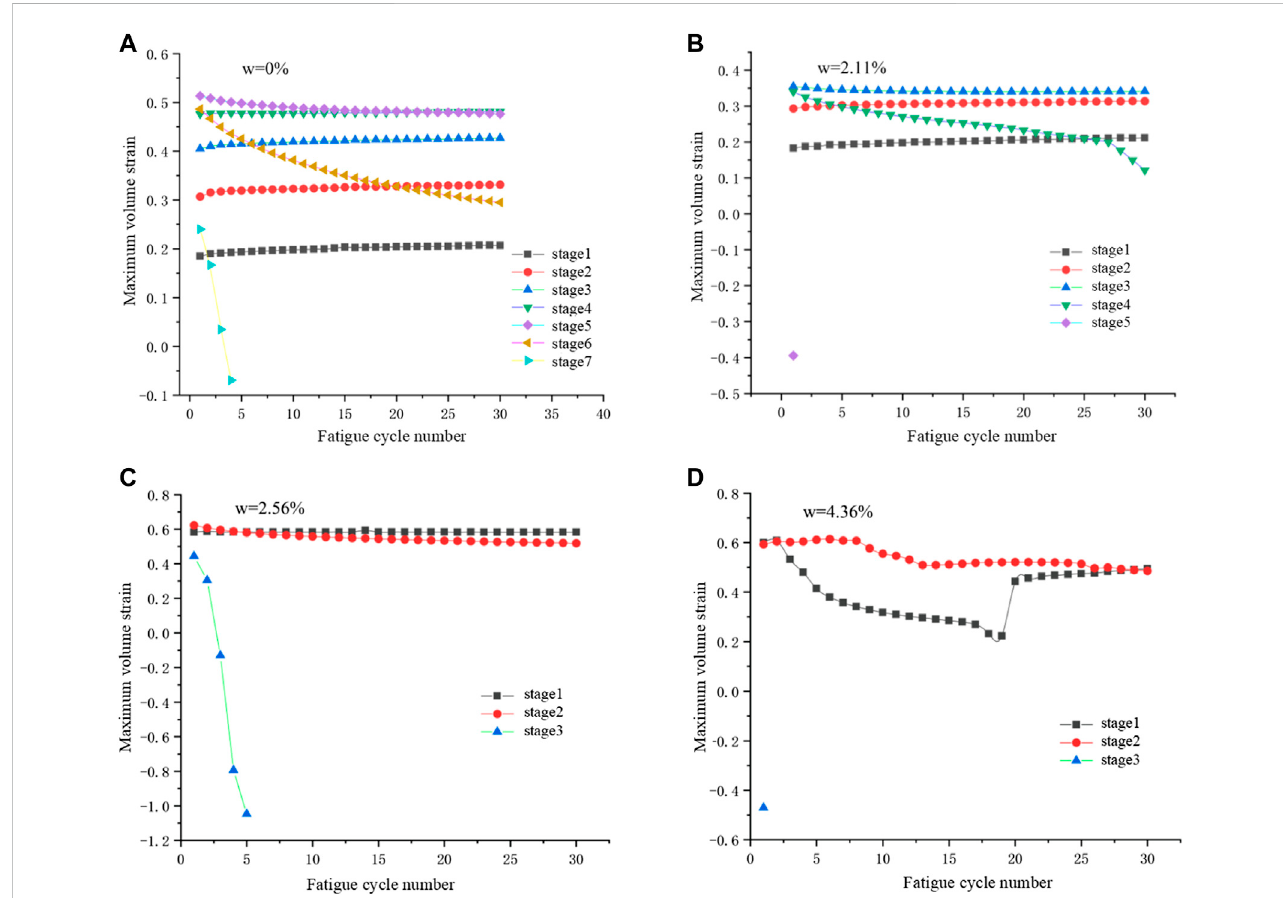
FIGURE 8 The aximum volumetric strain versus cyclic number at various cyclic loading stage (A – D) : The rock with water content of 0%, 2.21%, 2.56%, and 4.36%, respectively).